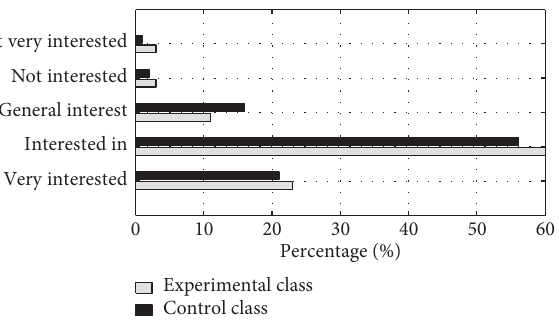
Figure 7: Learners’ interest in the teaching